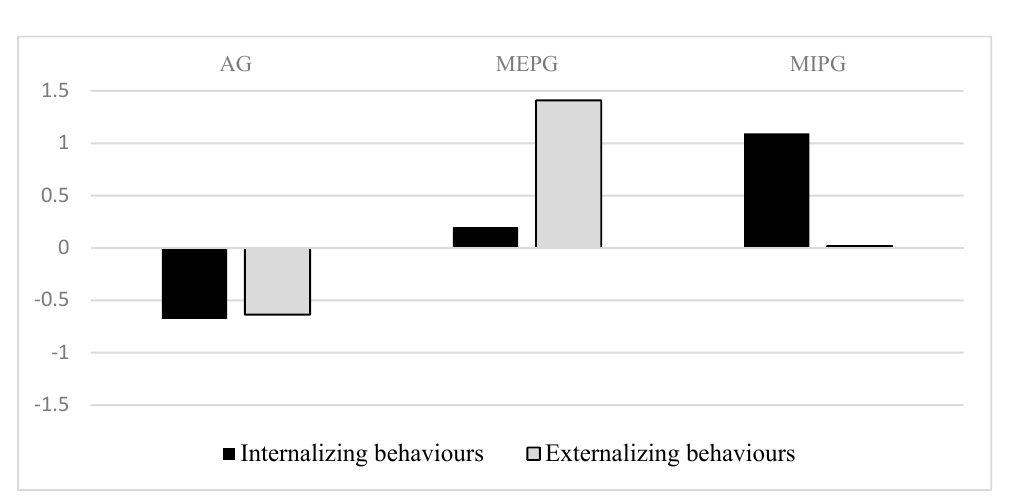
Figure 1. Conglomerate centers offered in typified scores.